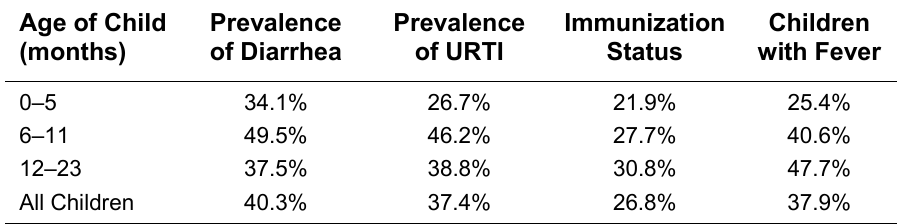
Prevalence of Fever, Diarrhea, URTI, and Immunization Coverage